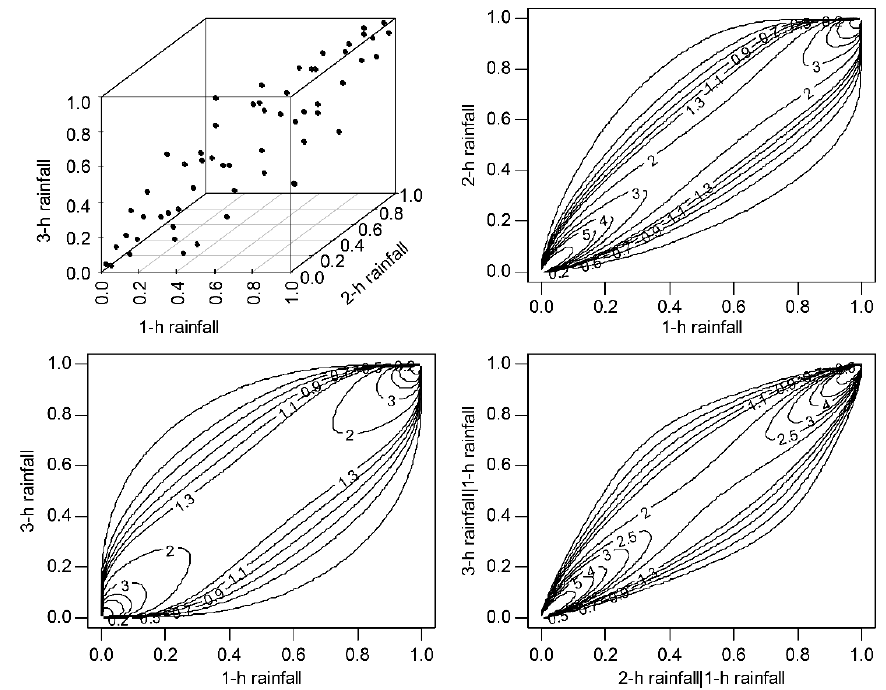
Figure 5. 3-D scatter plot of pseudo data and fitted copula densities for 1-h / 2-h, 1-h / 3-h, and conditional 2-h / 3-h rainfall amounts.